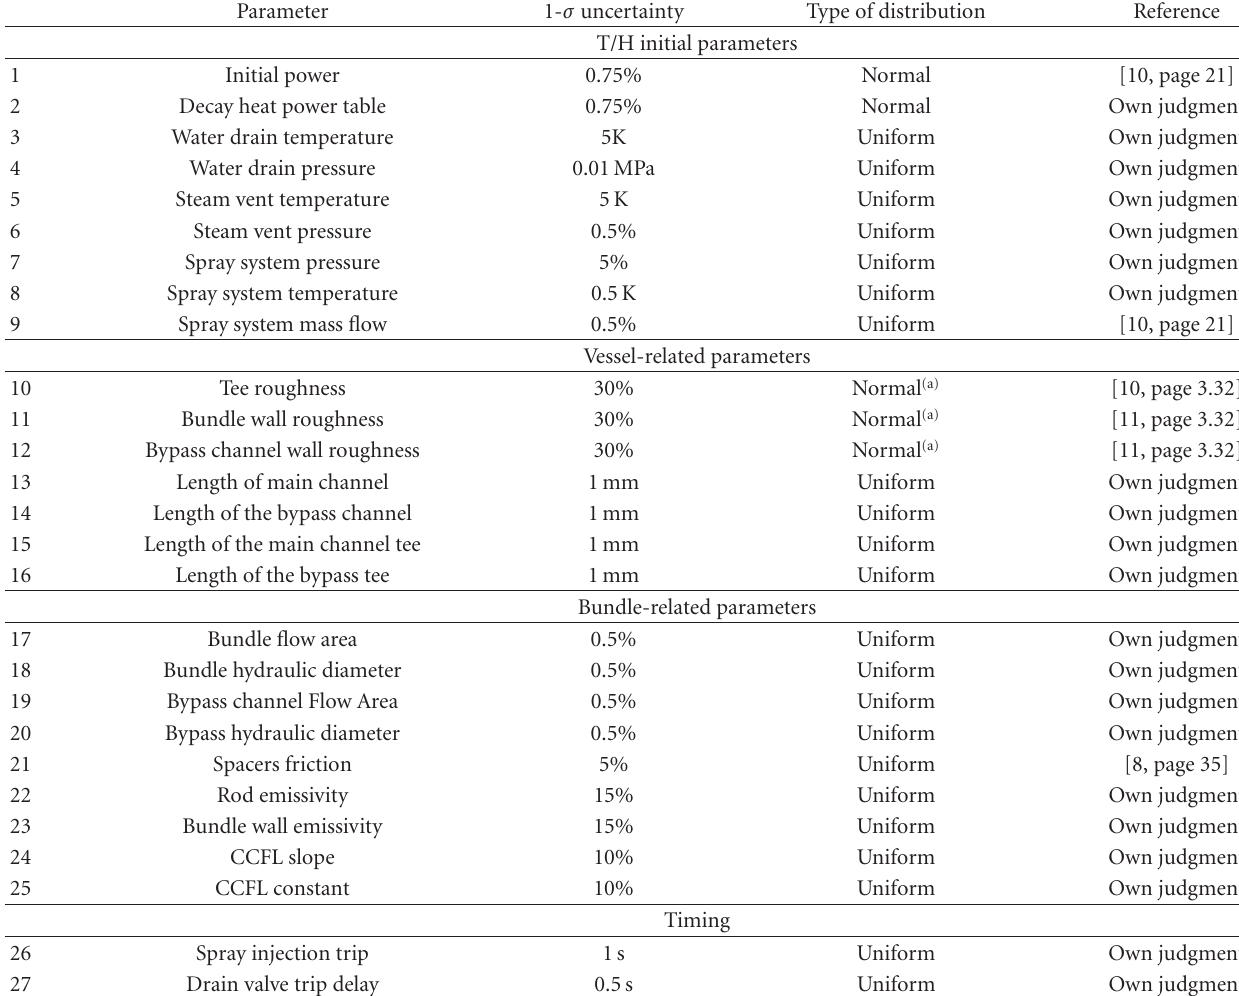
Table 4: Uncertain